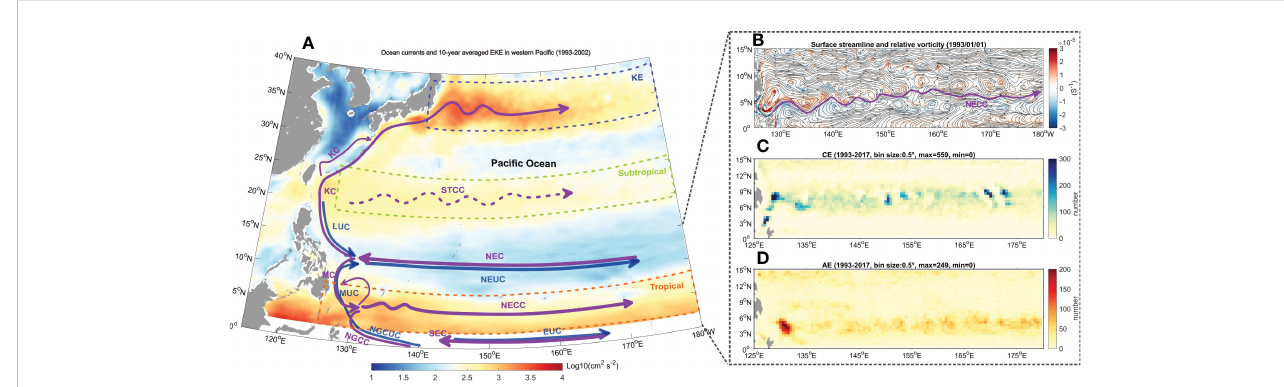
FIGURE 1 (A) Schematic map of the ocean circulation and 10-year averaged eddy kinetic energy (EKE, 1993 – 2002) based on AVISO data and three typical eddy- rich regions in the Paci fi c; (B) snapshot of the surface streamline, relative vorticity based on the European Copernicus Marine Environment Monitoring Service (CMEMS) datasets (1993/01/01); and the frequency statistics of all (C) cyclonic eddies (CEs) and (D) anticyclonic eddies (AEs) locations in the tropical region. The three eddy-rich regions are the Kuroshio Extension (KE), the subtropical regions, and the tropical regions, within the dotted frame in (A) . The colored lines with arrows indicate the circulation pattern in the Paci fi c Ocean (Hu et al., 2015; Qiu et al., 2015), including the Kuroshio (KC), Luzon Undercurrent (LUC), Subtropical Counter Current (STCC), North Equatorial Current (NEC), North Equatorial Undercurrent (NEUC), Mindanao Current (MC), Mindanao Undercurrent (MUC), North Equatorial Counter Current (NECC), South Equatorial Current (SEC), Equatorial Undercurrent (EUC), New Guinea Coastal Current (NGCC), and New Guinea Coastal Undercurrent (NGCUC). The data in (C, D) are binned in 0.5°×0.5° cells for the 1993 – 2017 period. Note that the locations in (C, D) are centers of mesoscale eddies (MEs), and the active regions of MEs are also in fl uenced by their